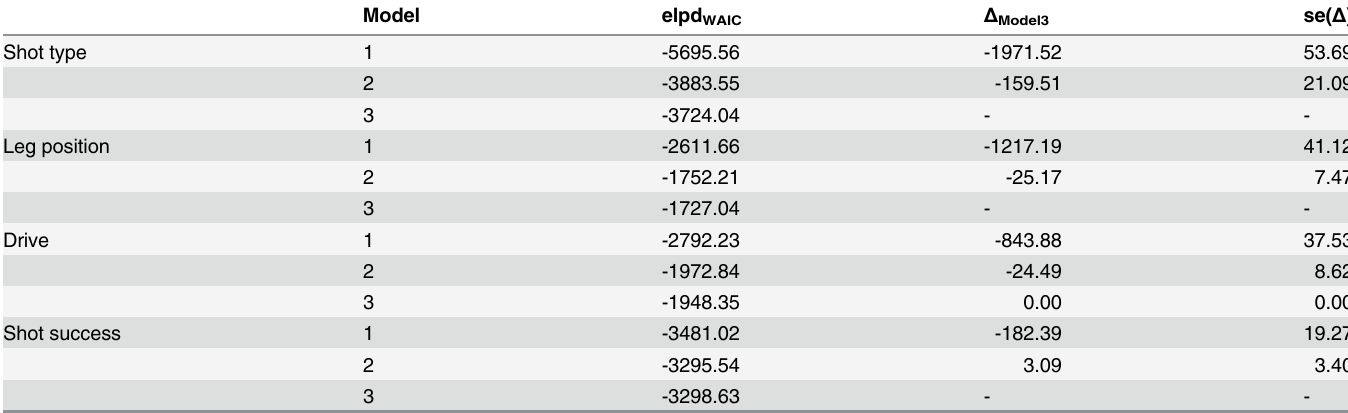
Table 2. Model evaluation and